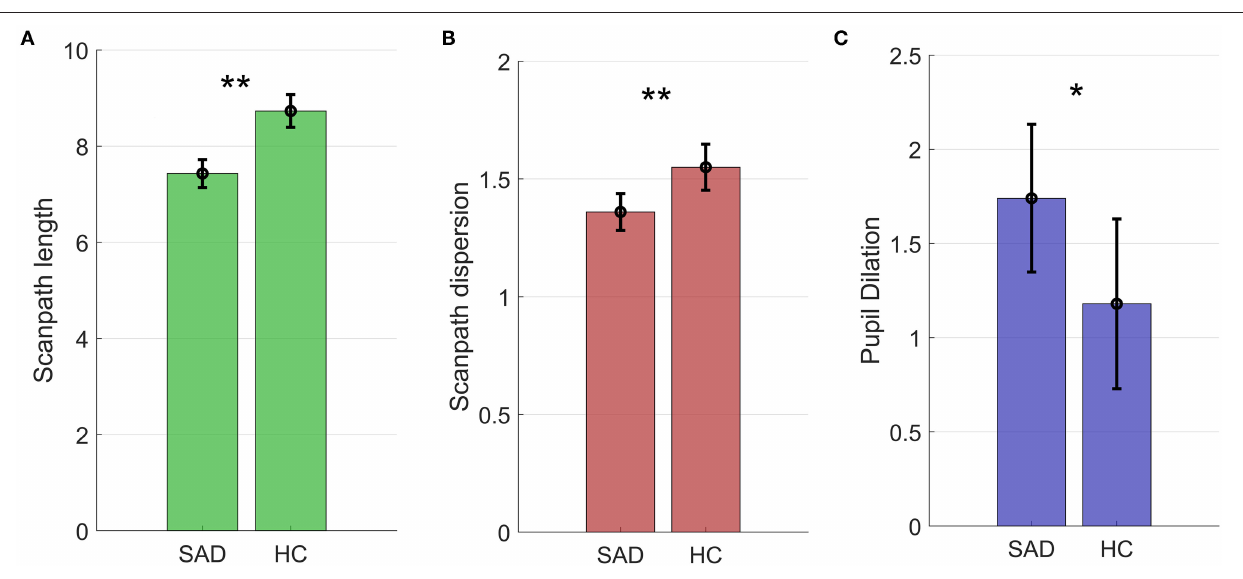
FIGURE 3 | Scanpath length in degrees of the visual field (A) , scanpath dispersion (B) , and pupil dilation (C) in the SAD and HC groups. Figures show estimated marginal means and 95% confidence intervals * p < 0.01; ** p <